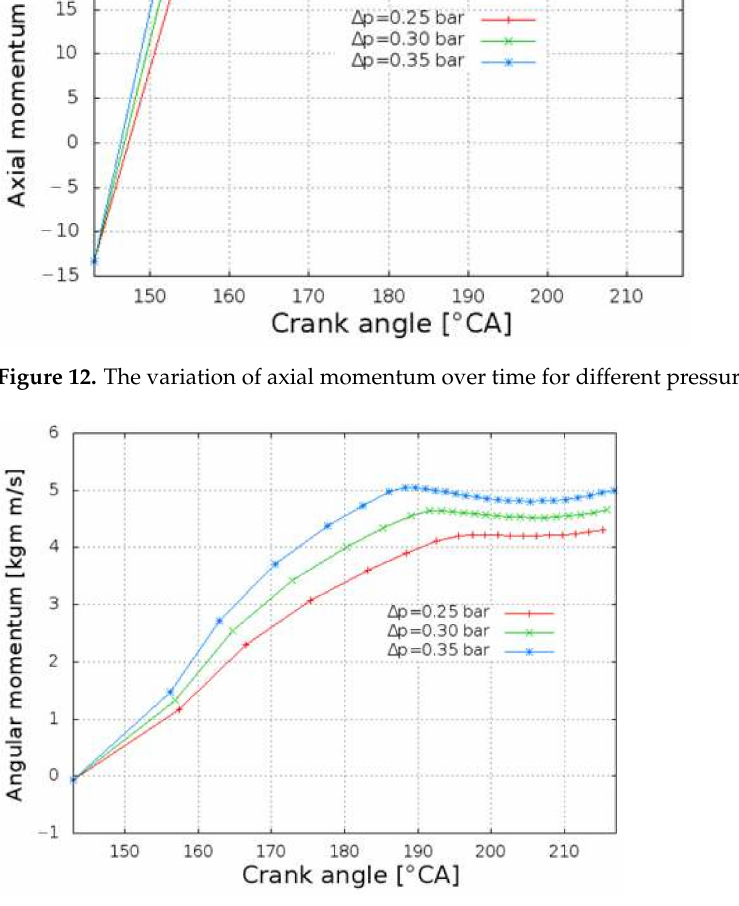
Figure 13. The variation of angular momentum over time for different pressure